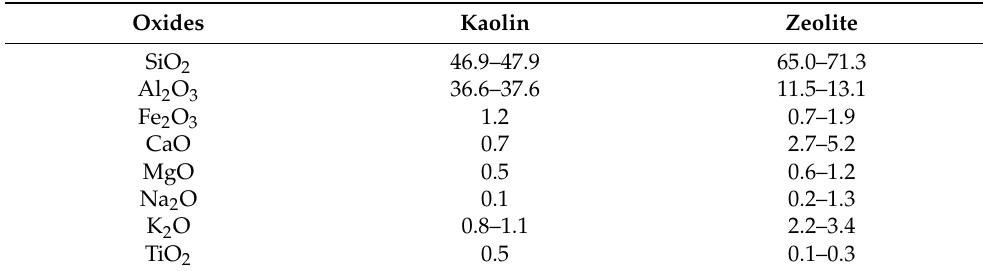
Table 1. The chemical compositions of the Sedlec kaolin and natural zeolite (in mass%). Oxides